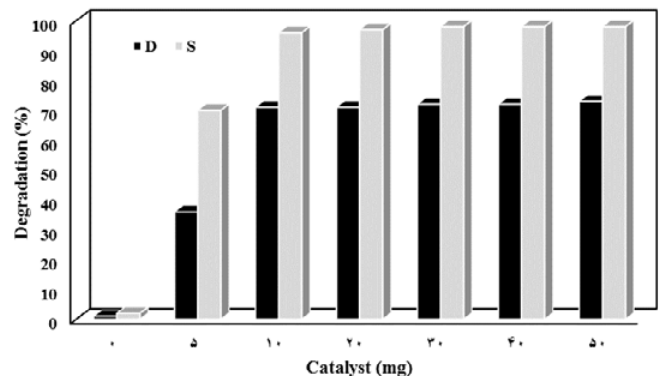
Fig. 10. Effect of the adsorbent amount over degradation of MO (20 mL solution of 6.5 ppm MO, pH = 3.1, t = 60 min).